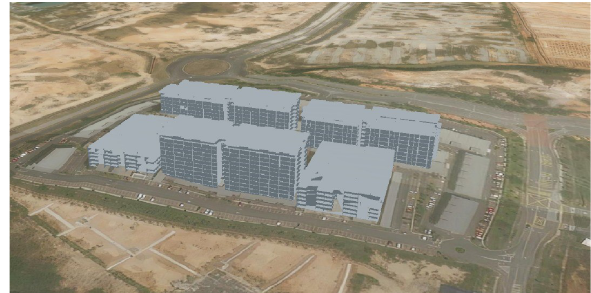
Figure 5 . The scheme of 12778 converted from Strata XML to CityGML with Strata ADE. Visualized in SKiP portal .